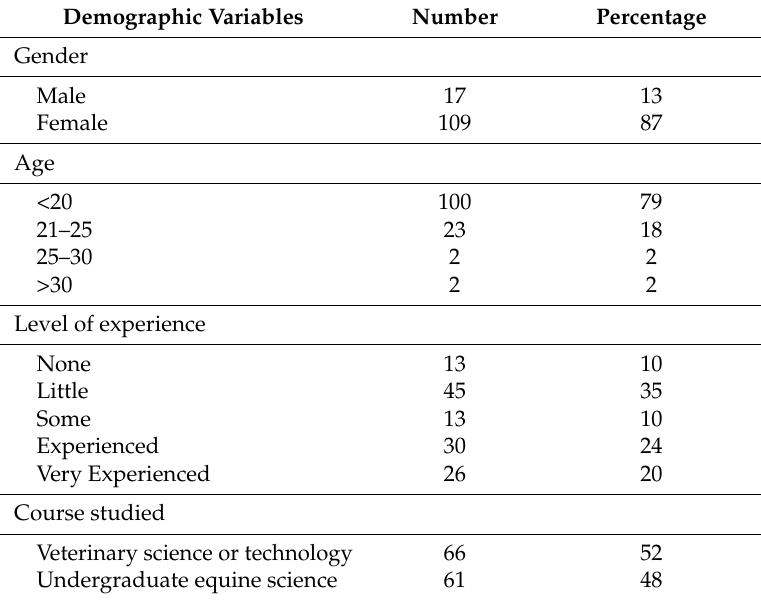
Table 3. The number and percentage of first-year veterinary science or veterinary technology and undergraduate equine science students, by gender, age, and level of previous experience with horses, used in a study to assess students’ interpretation of expressive horse